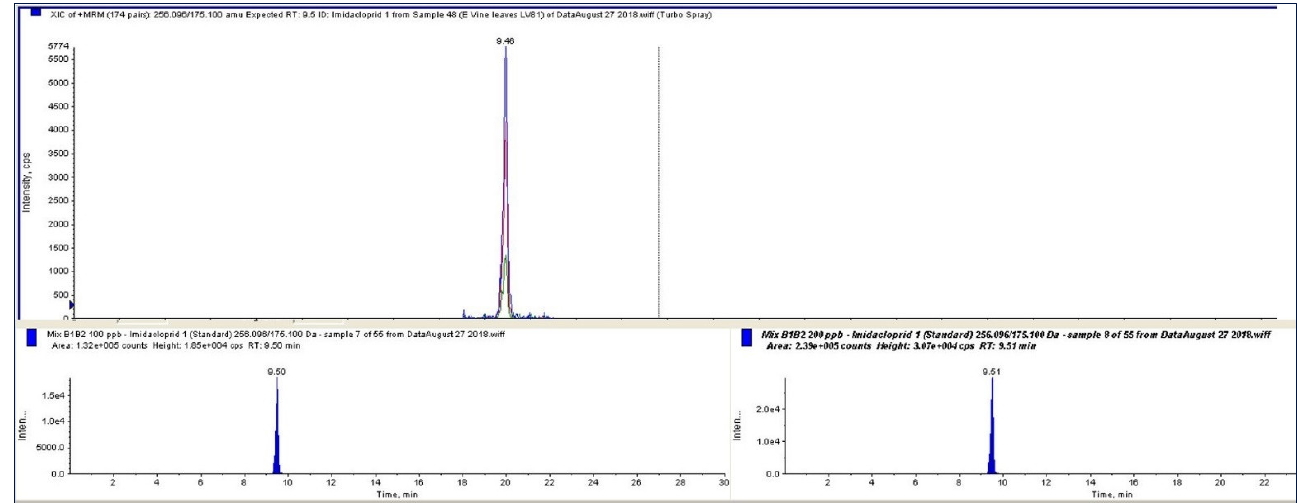
Figure 3. Total ion chromatogram (TIC) of the MRM of imidacloprid and the extracted ion chro- matogram for imidacloprid in vine leaves at 100 µg/L (lower left figure) and 200 µg/L (lower right